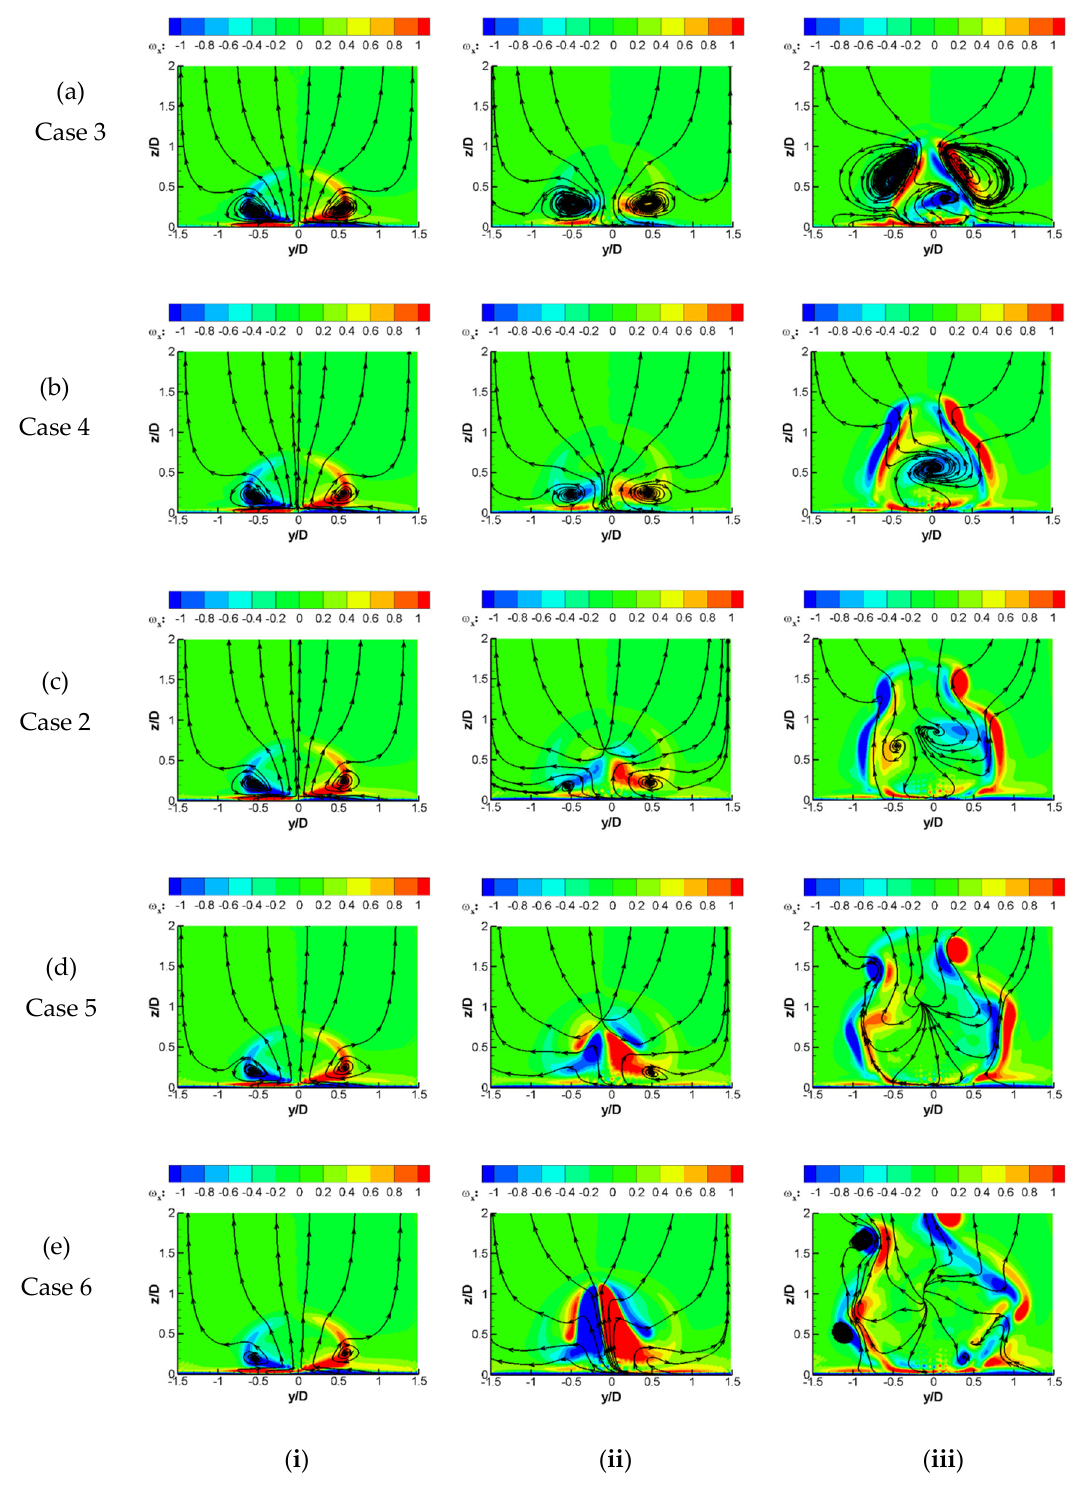
Figure 12. The contours of time-averaged streamwise vorticity ω x on the cross sections of ( i ) x / D = 1.0, ( ii ) x / D = 3.0, and ( iii ) x / D = 5.0 of double rows film cooling with various backward-downstream-jet blowing ratios of ( a ) BR = 0.20, ( b ) BR = 0.35, ( c ) BR = 0.50, ( d ) BR = 0.65, and ( e ) BR = 0.80 .